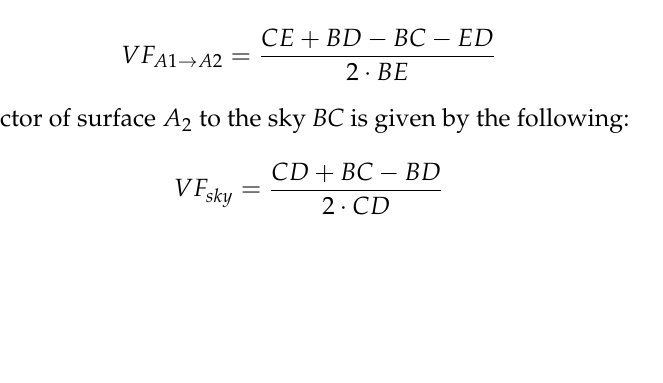
to surface 𝐴2 and surface 𝐴2 to sky 𝐵𝐶 . (cid:2869)